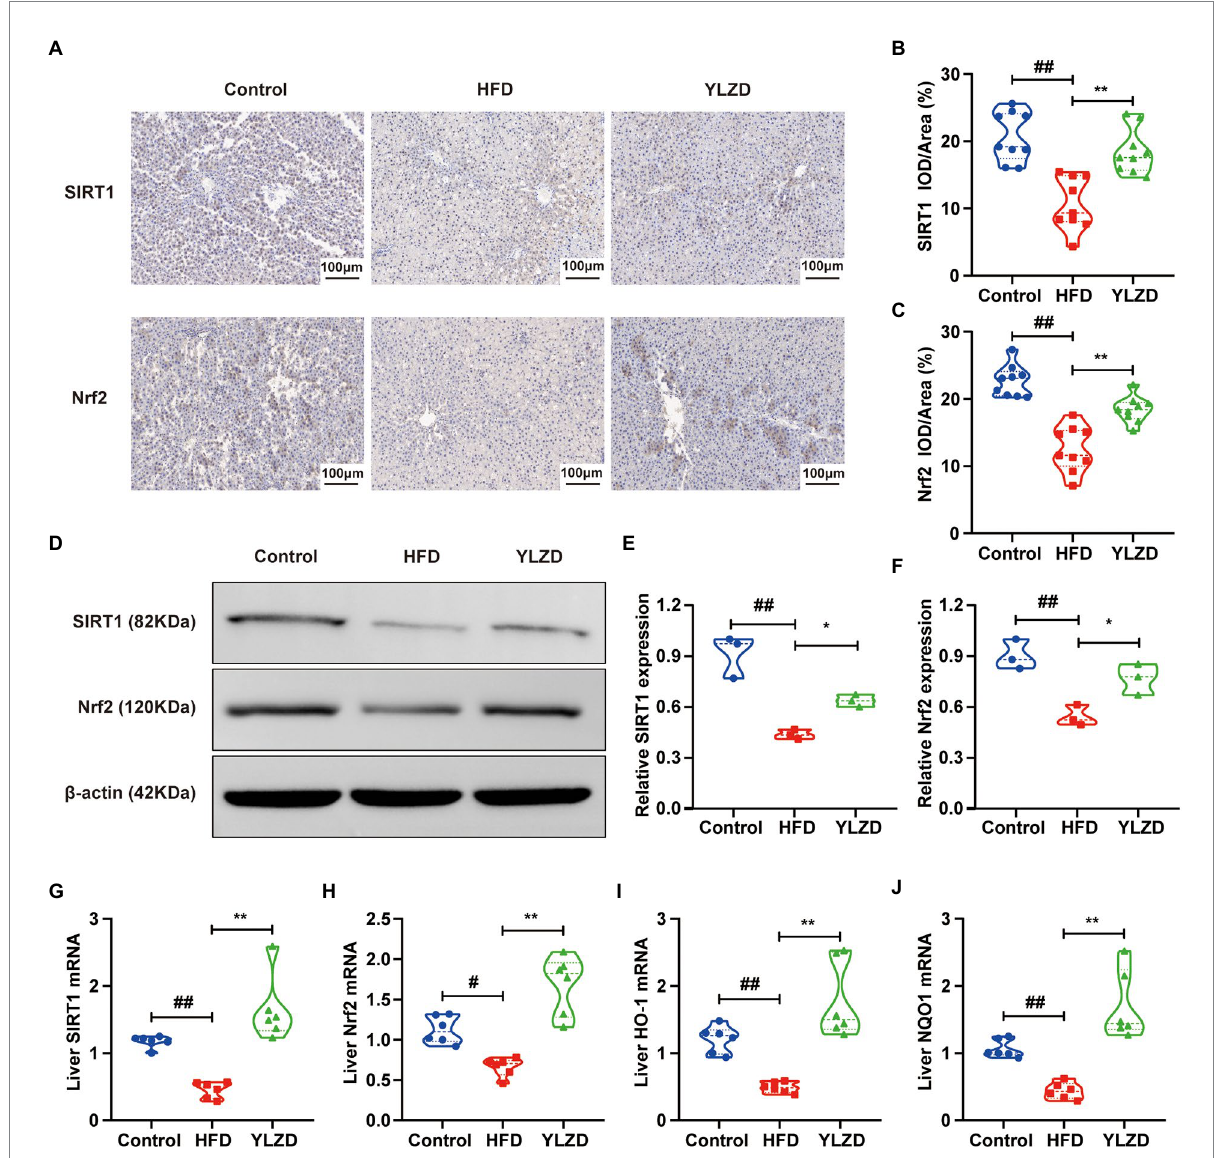
FIGURE 3 YLZD upregulated the expression levels of hepatic SIRT1/Nrf2 pathway-related genes and proteins. (A) Typical IHC staining images of the liver with different treatments (magnification, ×200). (B,C) Average optical density values (AOD = IOD/Area) of SIRT1 and Nrf2 protein expression. (D) Expression of transcription factors associated with SIRT1/Nrf2 pathway were detected by Western blot. (E,F) Quantification of the corresponding Western blotting results in D. (G–J) RT-qPCR of relative mRNA expression of SIRT1 , Nrf2 , HO-1 and NQO1 in liver. Values are represented as mean ± SEM ( n = 6 rats/group). ## p < 0.01, # p < 0.05 versus the Control group; ** p < 0.01, * p < 0.05 versus the HFD